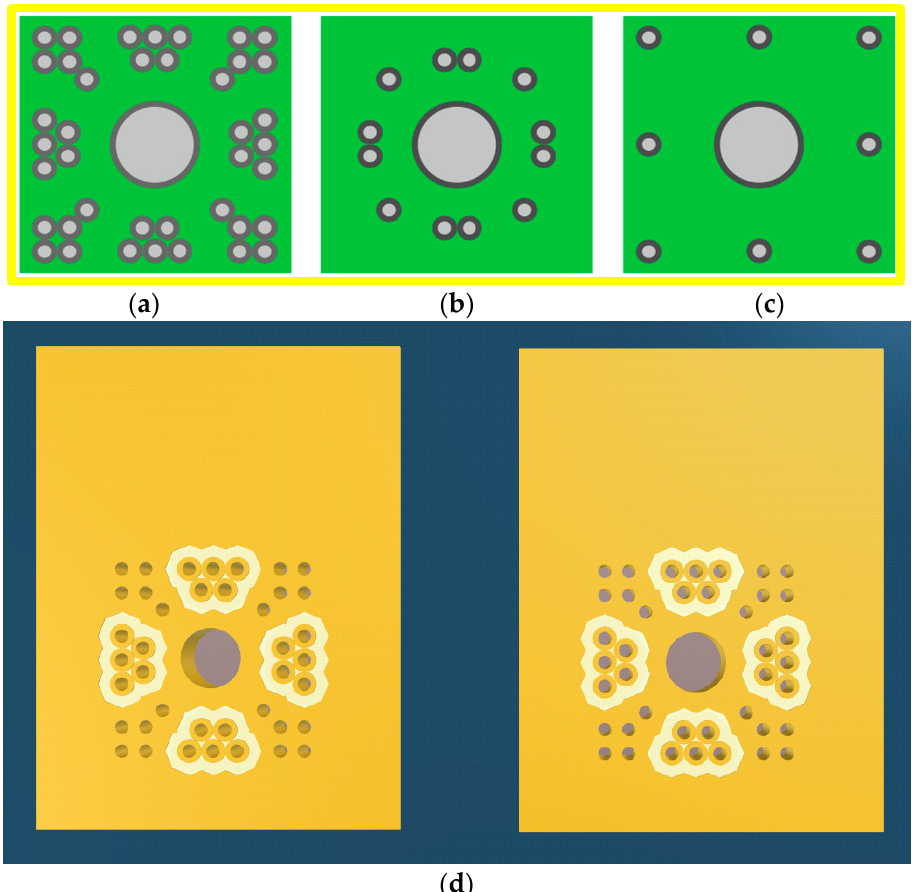
Figure 12. The transistors’ thermal via pattern in the model of the board PCB: ( a ) all vias—equivalent to the experimental setup; ( b ) reduced model with 12 vias; ( c ) model with 8 vias; ( d ) design for experimental tests (in ALTIUM Designer software—3D perspective).